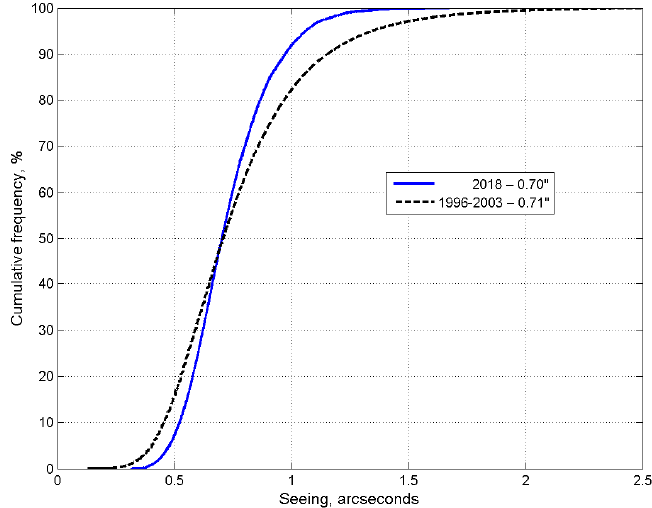
Figure 3. Cumulative distribution of astronomical seeing for the period August–November, 2018 and from 1996 to 2003.